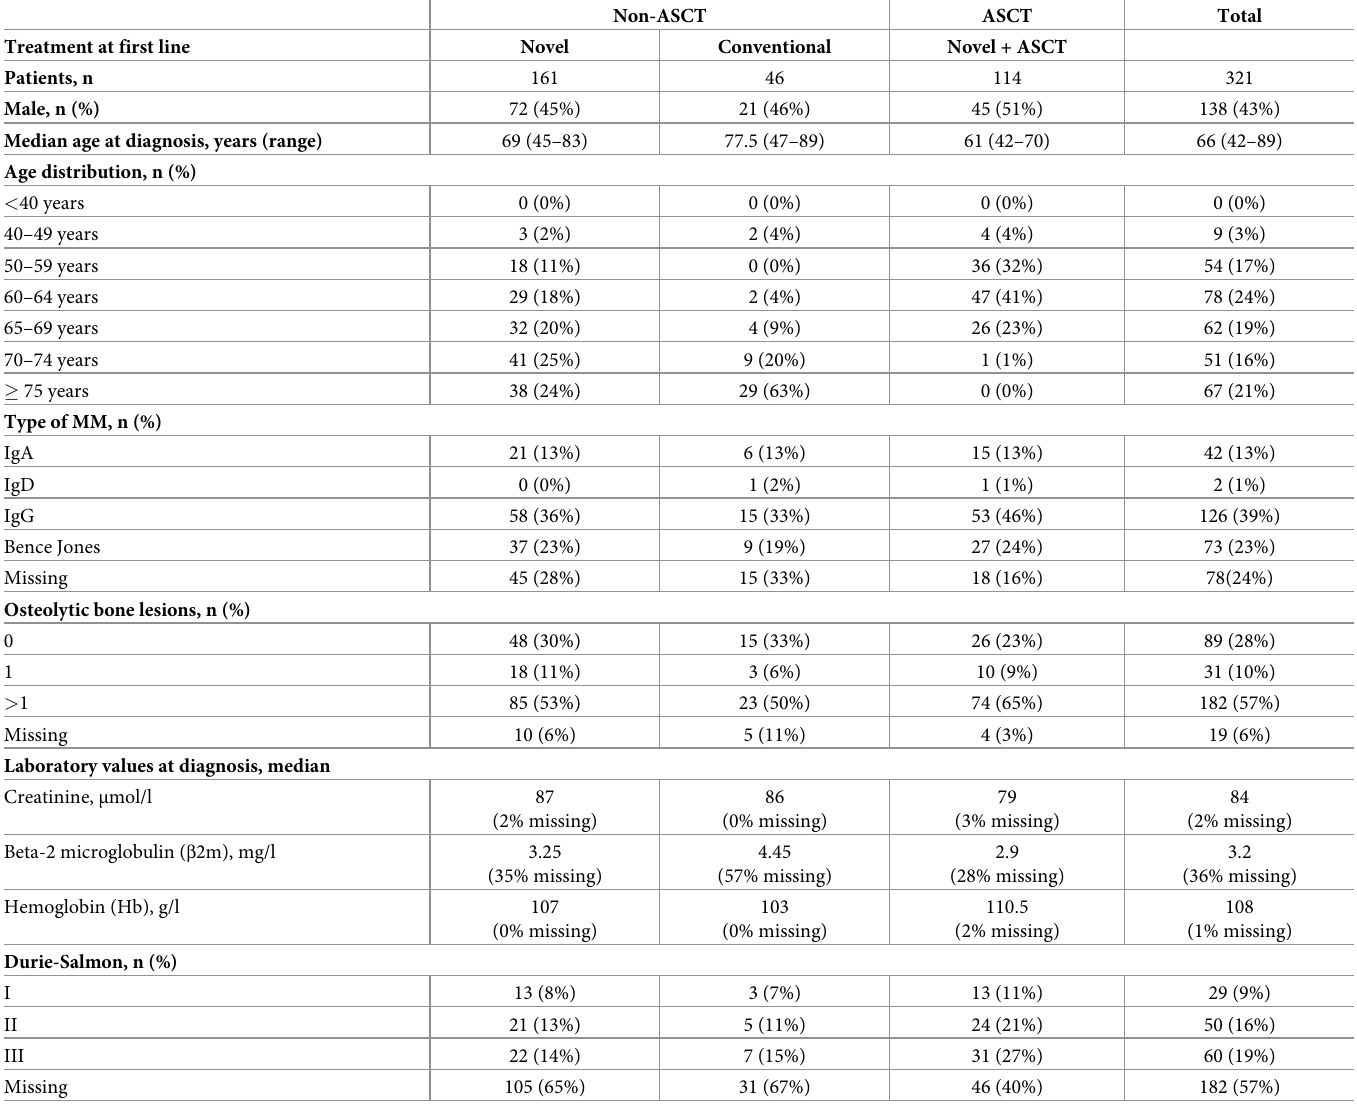
Table 1. Demographic details of patients included in the